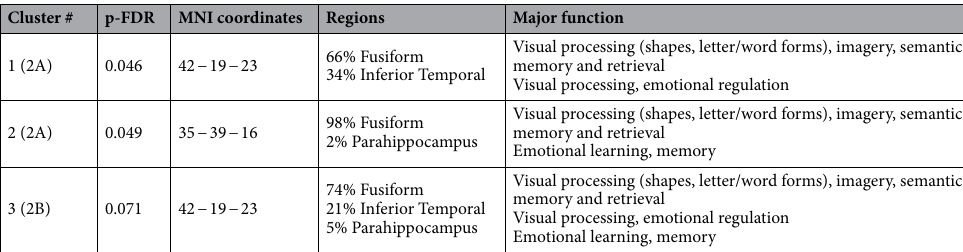
Visual processing (shapes, letter/word forms), imagery, semantic memory and retrieval Visual processing, emotional regulation Emotional learning,